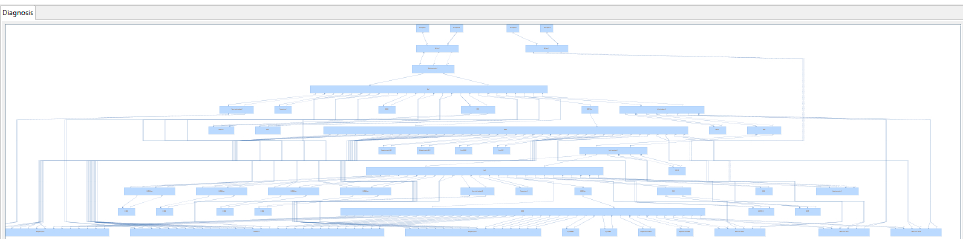
Figure 18. The complete model graph as displayed in the diagnosis view of the telemetry client.